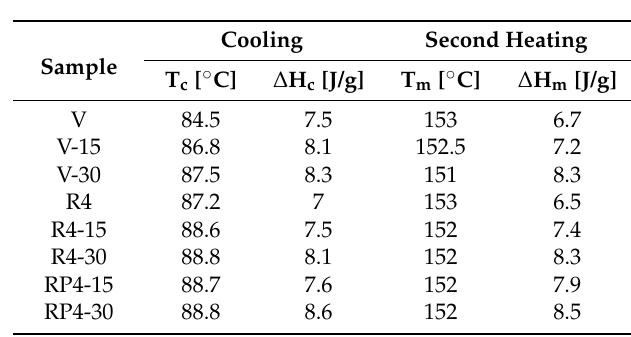
Table 7. DSC data ( T c = crystallization temperature, T m = melting temperature, Δ H c = crystallization enthalpy, Δ H m = melting enthalpy) for second heating and cooling runs of all of the samples (abbreviations as in Table 5).